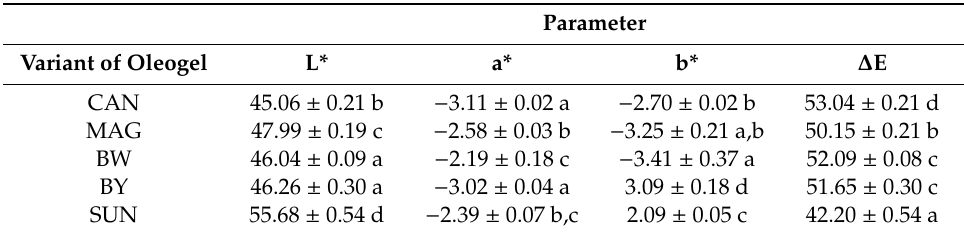
Table 3. The results of the determination of the color of oleogels, determined by three parameters: L*, a*, b* and absolute color di ff erence ∆